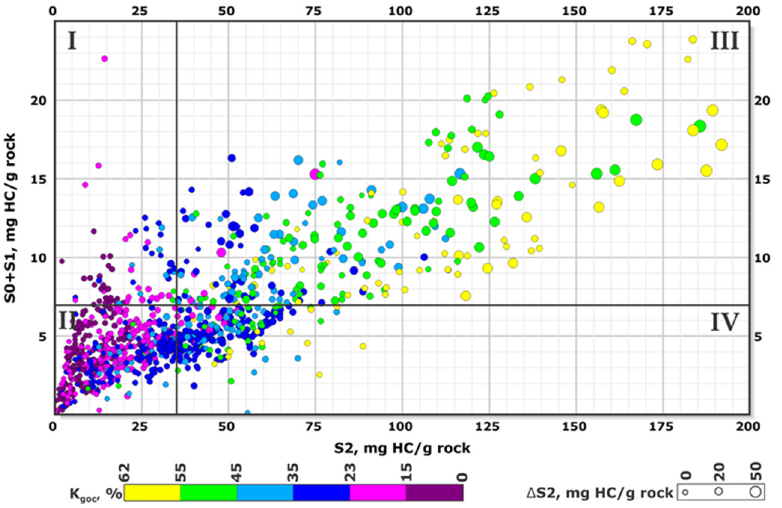
Figure 16. Diagram S 0 + S 1 vs. S 2 [26], Quadrants I–IV. The color indicates K goc , the proportion of generative organic carbon in TOC wt.%, and the size of dots reflects the content of Δ S 2 .